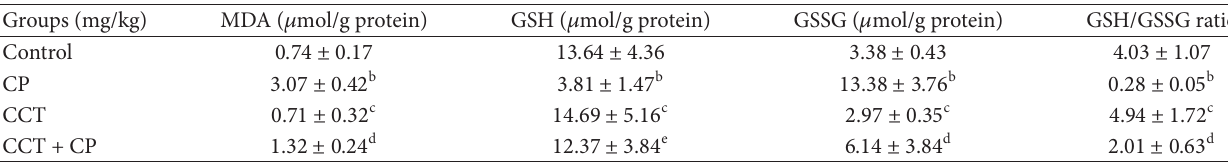
Table 2: Levels of MDA, GSH, GSSG, and GSH/GSSG ratio in bone marrow of mice after treatment with CCT (200 mg/kg) and/or CP (70